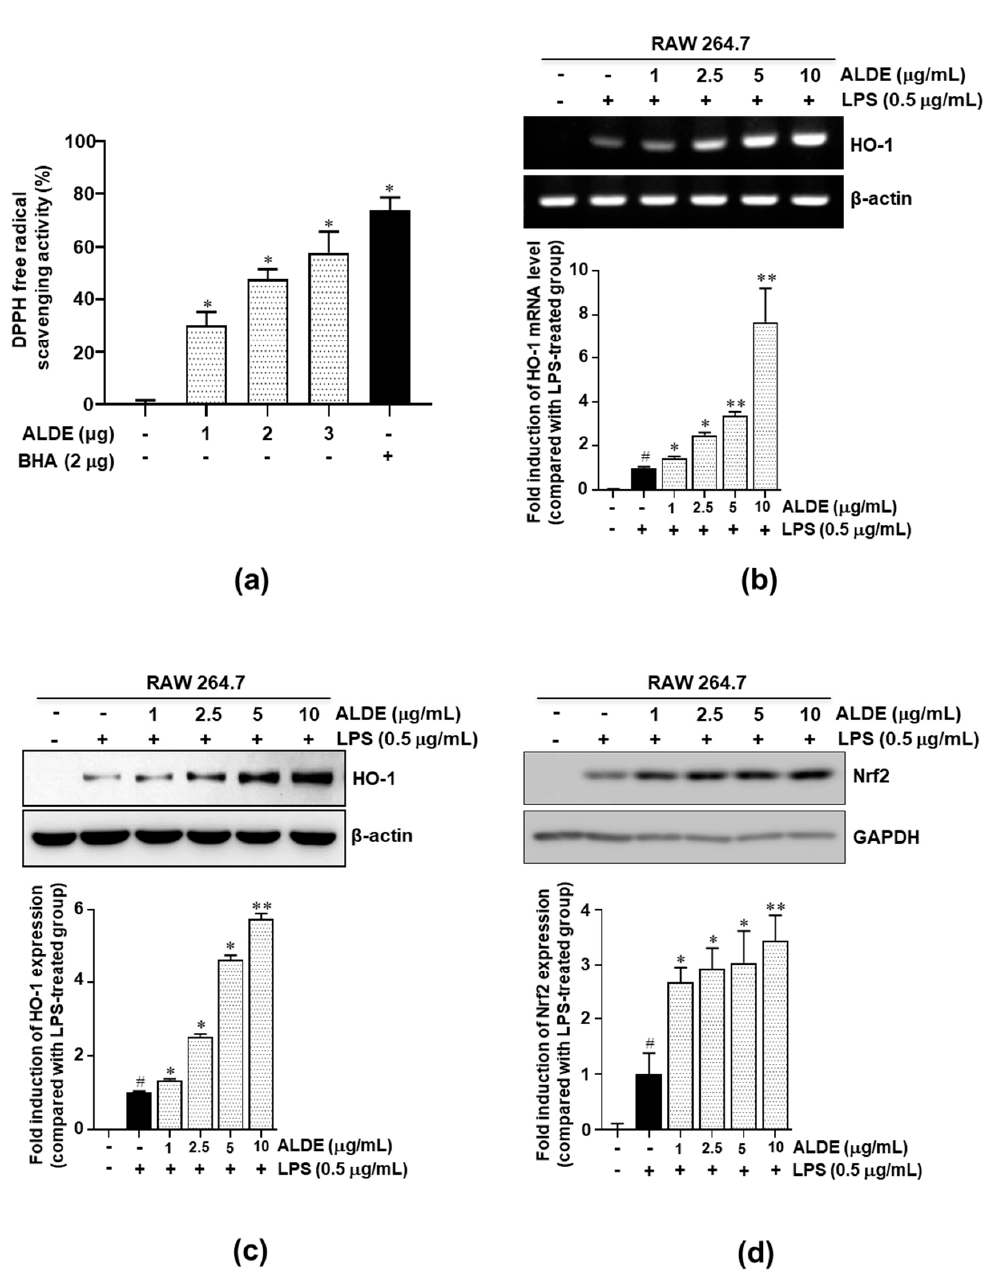
Figure 6. Antioxidative effects of ALDE. ( a ) DPPH free radical scavenging activity is represented as the mean ± SEM. ∗ p < 0.01 relative to the MeOH-reacted group. BHA was used as a positive control.